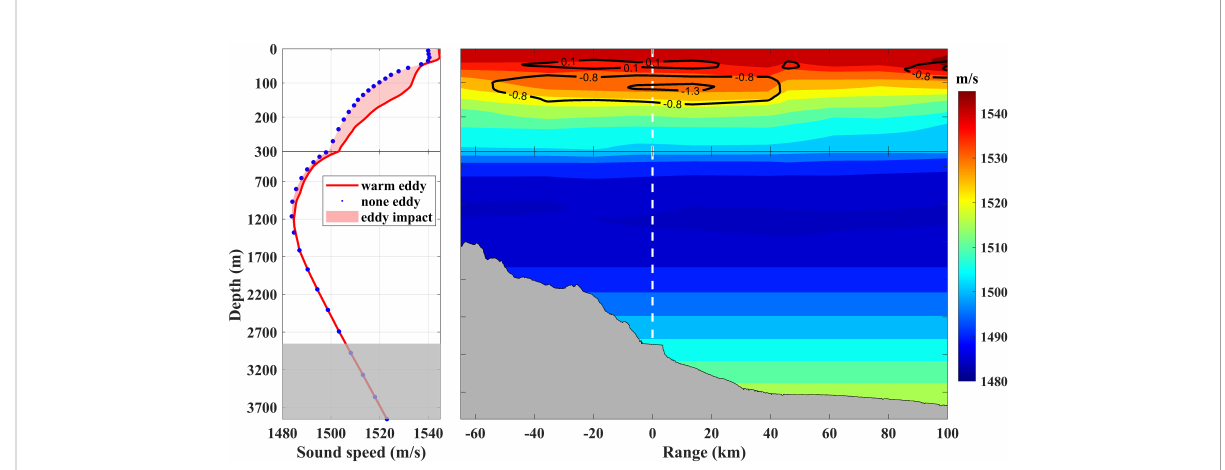
FIGURE 5 Sound speed (unit: m/s) of the section A. The SSPs in warm eddy (red solid line) and none eddy (blue dotted line) circumstances are shown in the left panel, and the red shadow area indicates the impacts of the warm eddy on sound speeds. The 2D sound speed distribution is shown in the right panel, an the black solid lines represent the anomalies of density induced by the warm eddy. The white dotted line indicates the position of VLA (R1), where SSP corresponds to the red one in the left